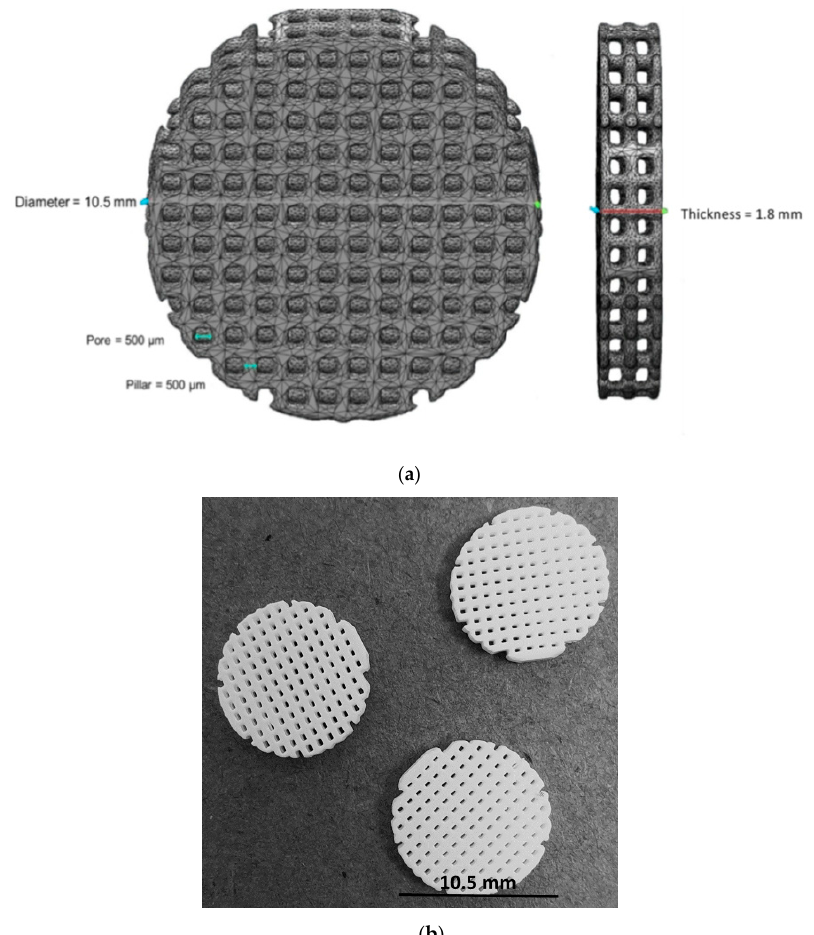
Figure 4. 3D printed macroporous β -TCP pellets used in this study. ( a ) 3D design of the pellets and ( b ) the printed pellets. ( b ) the printed